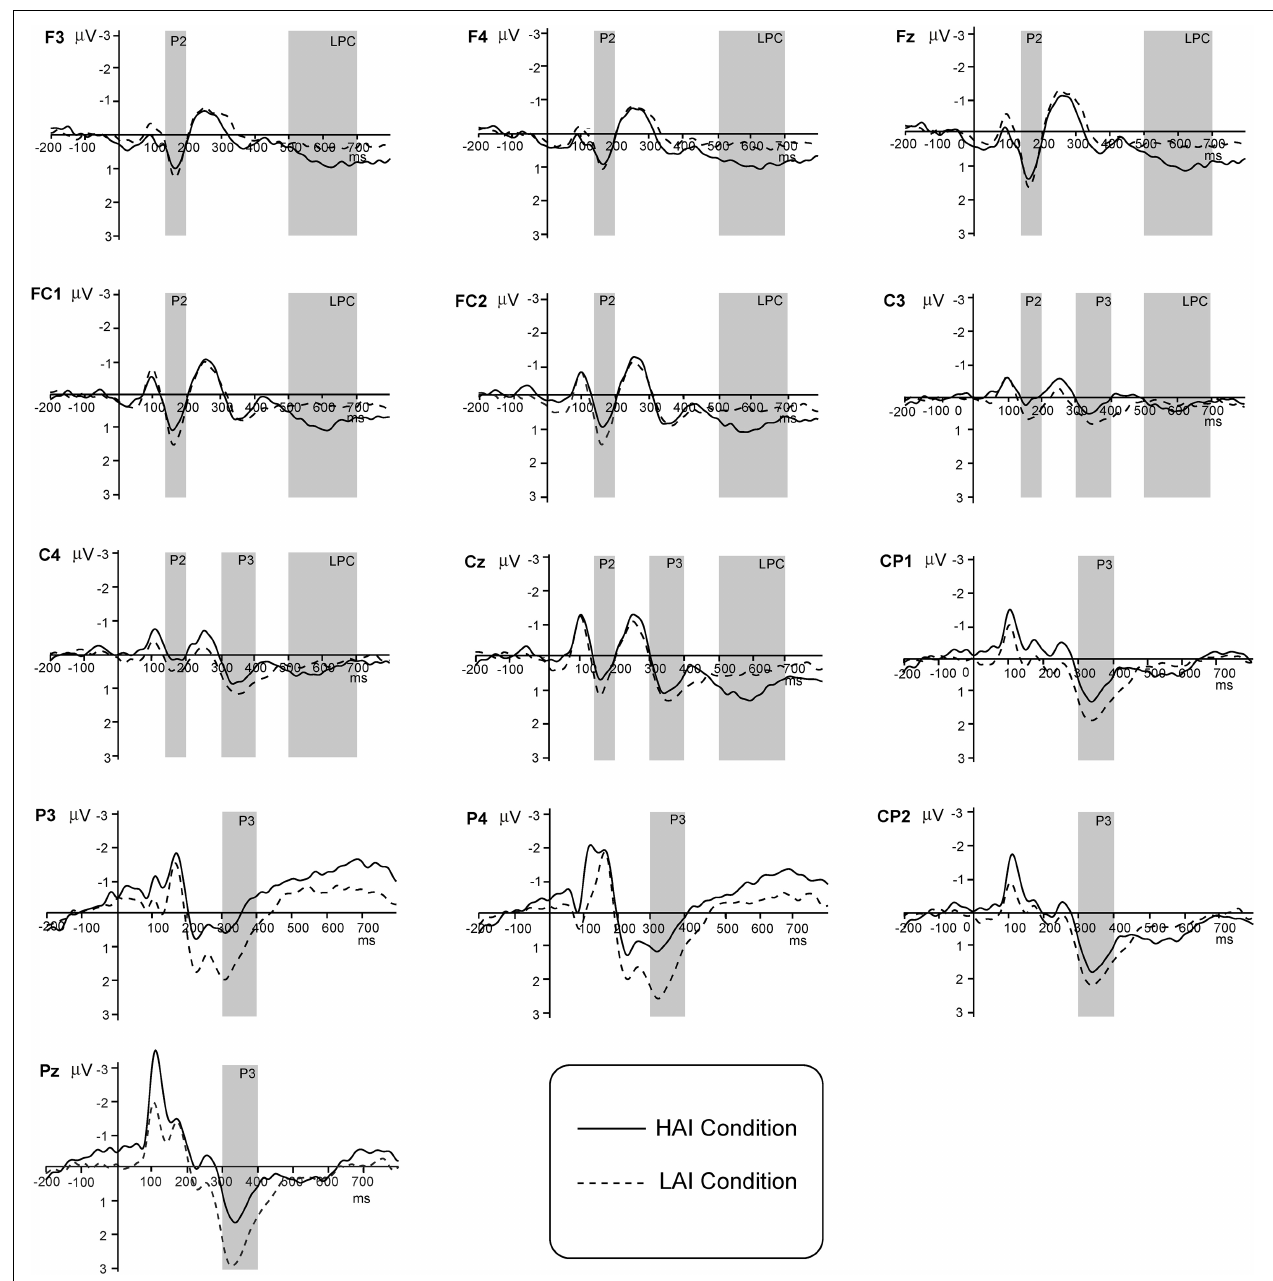
FIGURE 3 | Grand averaged event-related potentials (ERPs) of P2, P3, and late positive component (LPC) elicited by different amounts of information condition (high vs. low).